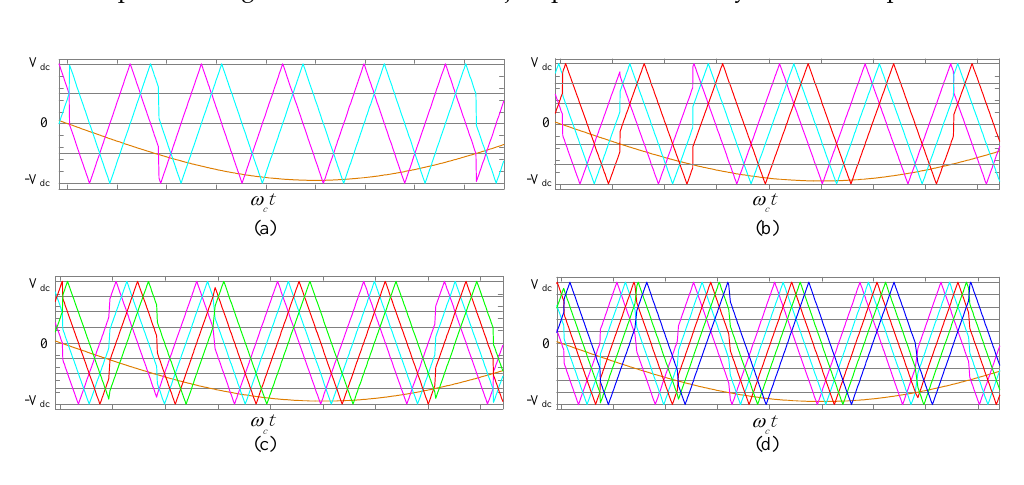
Figure 6. Carriers and reference under the optimized new strategy under CHB inverters of various levels. ( a ) New strategy for five-level CHB inverter. ( b ) New strategy for seven-level CHB inverter. ( c ) New strategy for nine-level CHB inverter. ( d ) New strategy for 11-level CHB inverter.